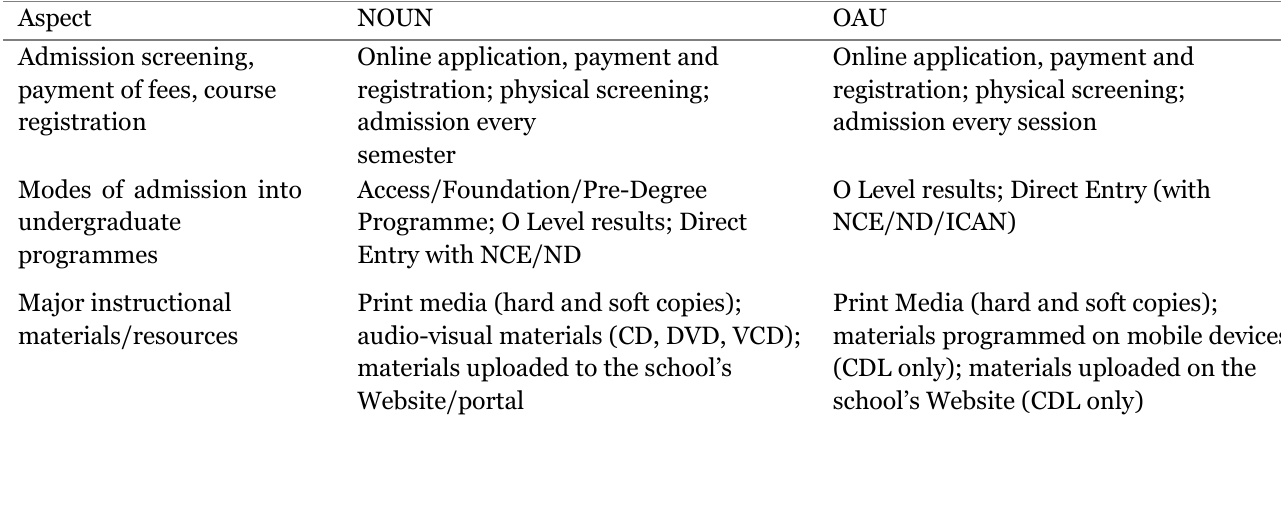
Summary of Operational Structures at NOUN and